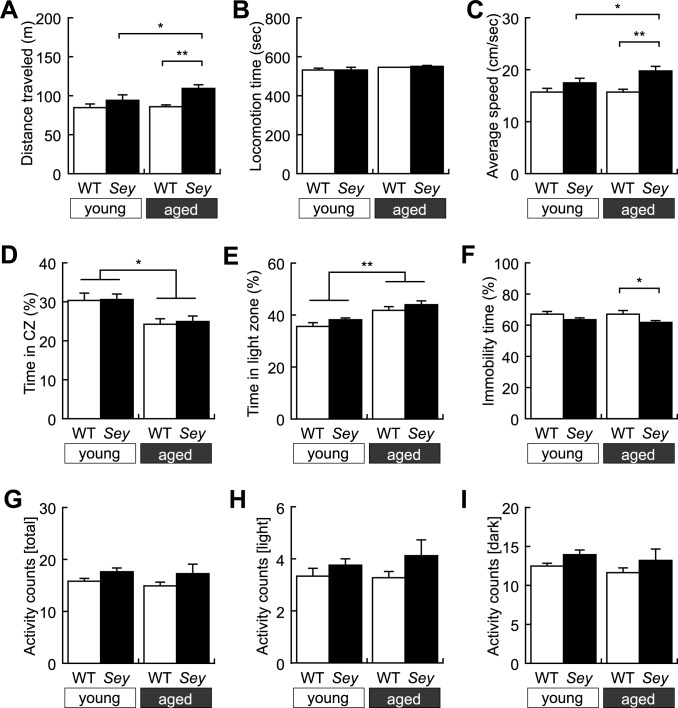
Hyperlocomotor activity and anxiety-like behaviors of WT and Sey/+ mice.Locomotor activity of each mouse was recorded in the open-field test. Histogram showing results of (A) distance traveled; two-way ANOVA: main effect of “genotype”; F = 10.985, p = 0.002, but no main effect of “father’s age”; F = 2.636, p = 0.112, and interaction (father’s age x genotype); F = 1.852, p = 0.181, (B) locomotion time; two-way ANOVA: no main effect of “genotype”; F = 0.054, p = 0.818, and “father’s age”; F = 3.020, p = 0.090, and interaction (father’s age x genotype); F = 0.123, p = 0.727, (C) locomotion speed; two-way ANOVA: main effect of “genotype”; F = 11.017, p = 0.002, but no main effect of “father’s age”; F = 2.640, p = 0.112, and interaction (father’s age x genotype); F = 1.852, p = 0.181, and (D) time spent in the center zone; two-way ANOVA: main effect of “father’s age”; F = 9.432, p = 0.004, but no main effect of “genotype”; F = 0.003, p = 0.959, and interaction (father’s age x genotype); F = 0.013, p = 0.911 in the open field test. Anxiety-related behavior of each mouse was recorded in the light/dark transition test. Histogram showing results of (E) time spent in the light zone; two-way ANOVA: main effect of “father’s age”; F = 17.315, p < 0.001, but no main effect of “genotype”; F = 2.332, p = 0.134 and interaction (father’s age x genotype); F = 0.027, p = 0.871 in the light/dark transition test. Depression-related behavior of each mouse was recorded in the tail suspension test. Histogram showing results of (F) ratio of immobility time; two-way ANOVA: main effect of “genotype”; F = 6.304, p = 0.016, but no main effect of “father’s age”; F = 0.328, p = 0.570, and interaction (father’s age x genotype); F = 0.220, p = 0.641. Locomotor activity in home cage of each mouse was recorded in the home-cage activity test. Histogram showing results of distance traveled (G) during all the day; two-way ANOVA: no main effect of “genotype”; F = 2.579, p = 0.116 and “father’s age”; F = 0.222, p = 0.640, and interaction (father’s age x genotype); F = 0.051, p = 0.822, (H) during the light period; two-way ANOVA: no main effect of “genotype”; F = 2.888, p = 0.097 and “father’s age”; F = 0.154, p = 0.697, and interaction (father’s age x genotype); F = 0.359, p = 0.552 and (I) during night period; two-way ANOVA: no main effect of “genotype”; F = 2.084, p = 0.156 and “father’s age”; F = 0.551, p = 0.462, and interaction (father’s age x genotype); F = 0.005, p = 0.942 in the home-cage activity test in WT and Sey/+ mouse pups born to young (3M) or aged (>12M) father. All data are presented by the mean ± SEM. *p < 0.05, ** p < 0.01, *** p < 0.001, determined by Bonferroni post hoc test. WT: wild type, Sey: Pax6 mutant.